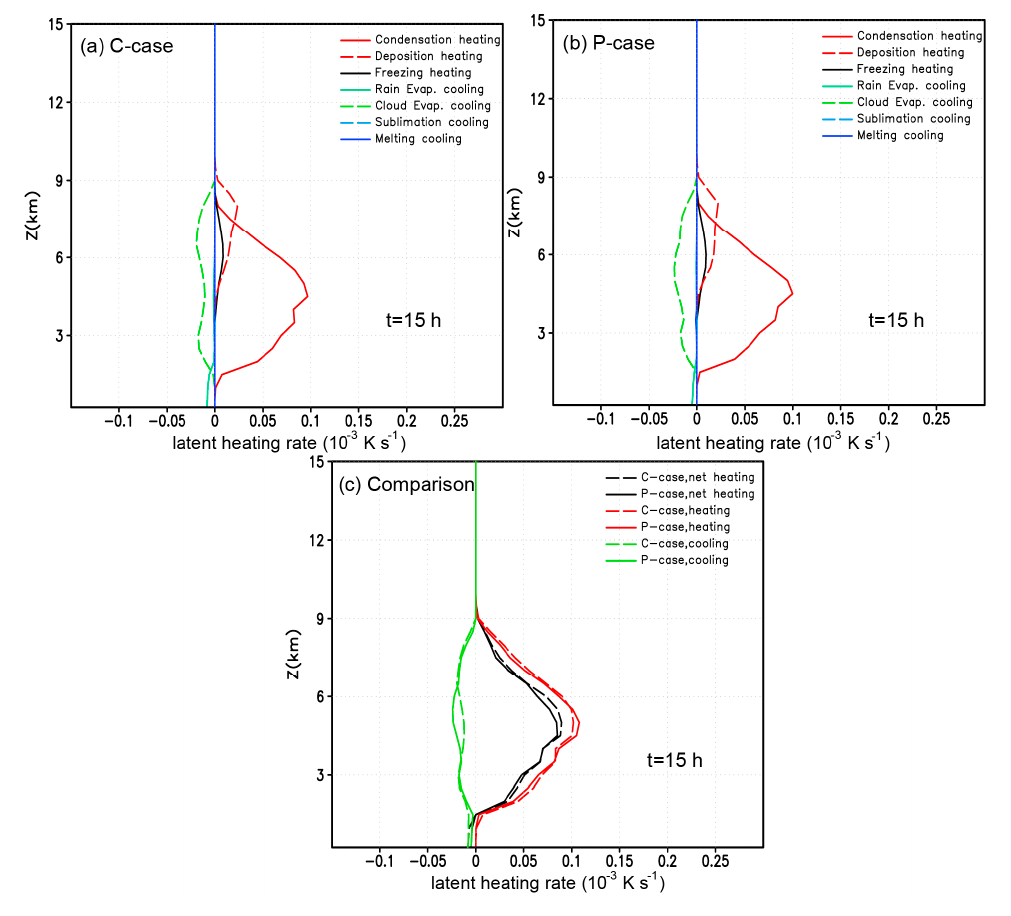
Figure 9. Vertical profiles of domain-averaged latent heating at t = 15 h (Units: 10 − 3 K s − 1 ) ( a , b ) latent heating rates of individual processes (left panel shows C-case, right panel shows P-case), ( c ) total latent heating (heating by condensation, freezing and deposition; cooling due to sublimation, melting and evaporation; net heating is the sum of heating and cooling).